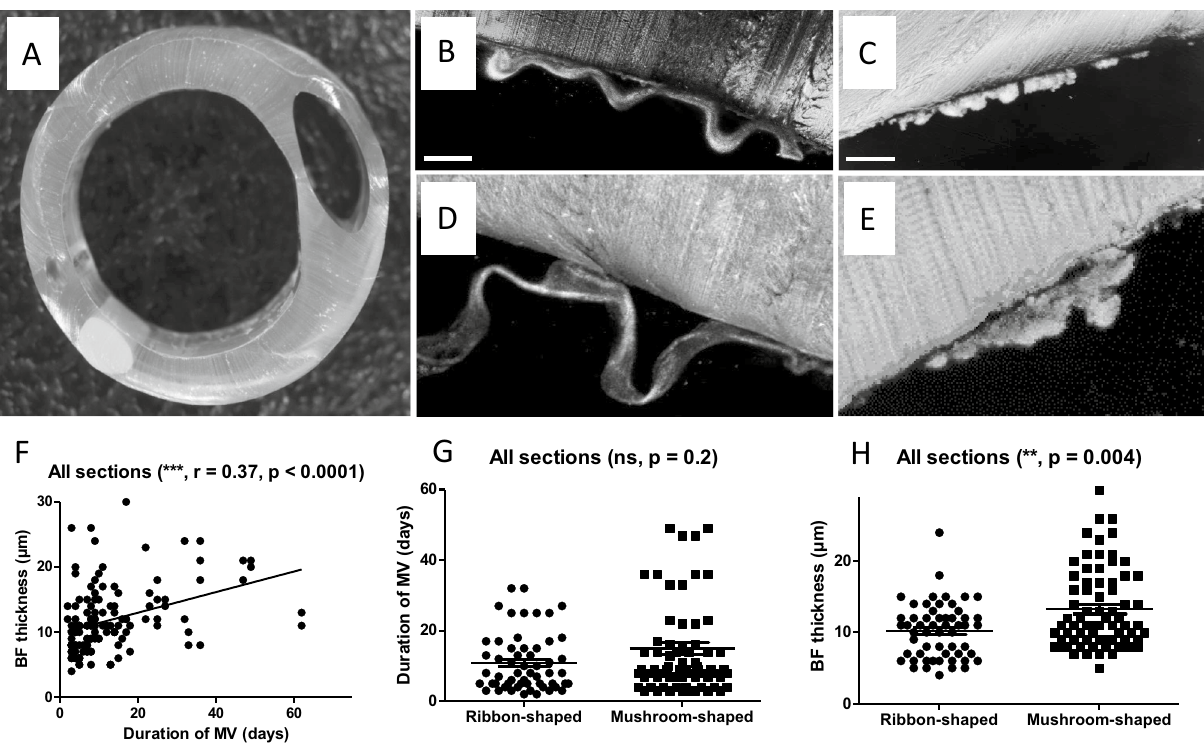
Figure 2. Mesostructural characterization of ETT-deposited BF. ( A ) Macroscopic view of ETT section before confocal microscopy ; ( B ) confocal image of an ETT section showing ribbon-shaped BF deposited on the inner surface (scale bar, 75 µm) ; ( C ) confocal image of an ETT section showing mushroom-shaped BF deposited on the inner surface (scale bar, 75 µm) ; ( D ) zoomed confocal image of an ETT section showing ribbon-shaped BF deposited on the inner surface (scale bar, 25 µm) ; ( E ) zoomed confocal image of an ETT section showing mushroom-shaped BF deposited on the inner surface (scale bar, 25 µm) ; ( F ) correlation curve between the length of MV duration and BF thickness ; ( G ) comparison of median MV duration between ribbon- and mushroom-shaped BF ; H. comparison of median BF thickness between ribbon- and mushroom-shaped BF. BF biofilm, ETT endotracheal tube, MV mechanical ventilation, ns not